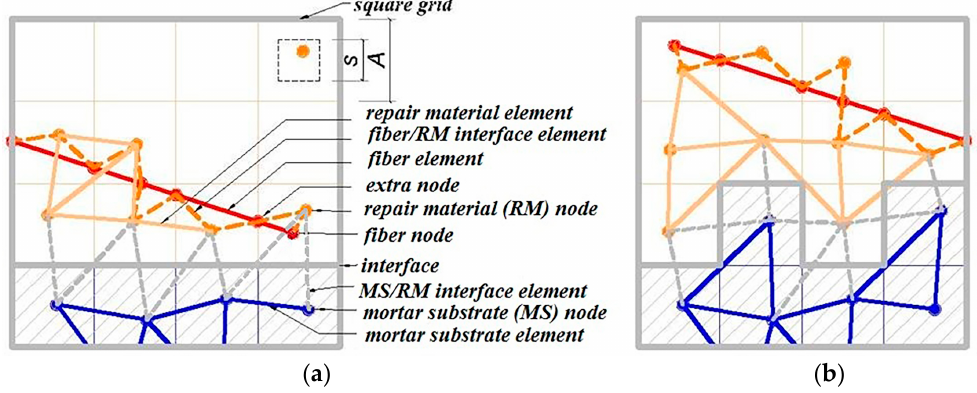
Figure 1. Two-dimensional overlay procedure for generation of the lattice model in the interface zone between the fibre reinforced repair material and ( a ) a smooth; and ( b ) a rough surface substrate.